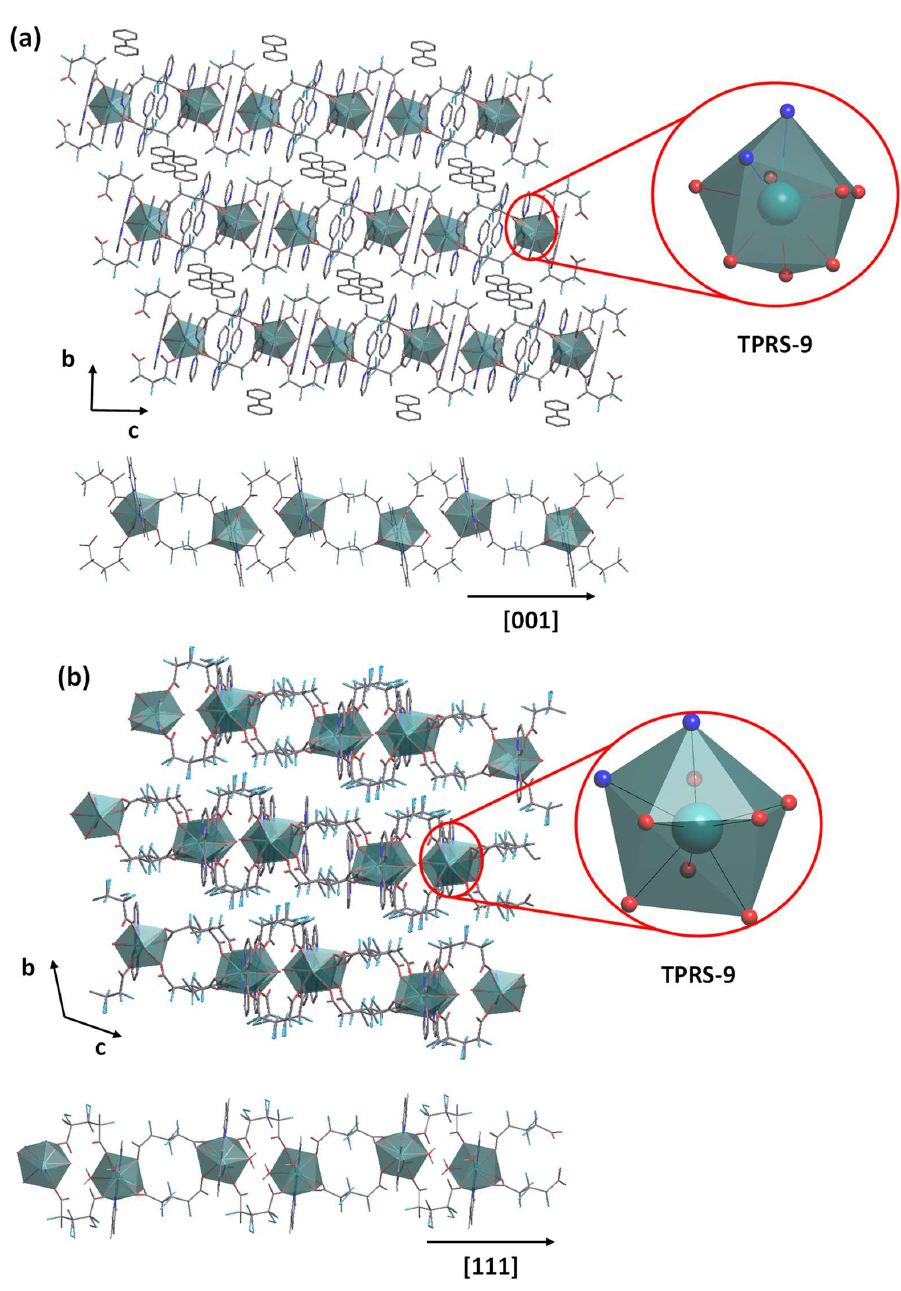
Figure 8. Crystal packing: 1D chains and coordination polyhedron for the compounds ( a ) α-Sm and ( b ) β-Sm .